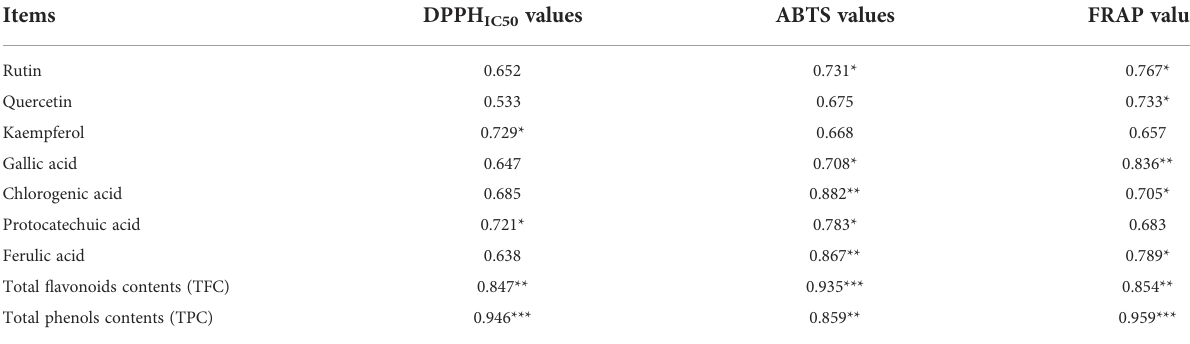
TABLE 3 Correlation coef fi cients between the phenolic pro fi les contents and antioxidant activity for different organs of S. Hexandrum .